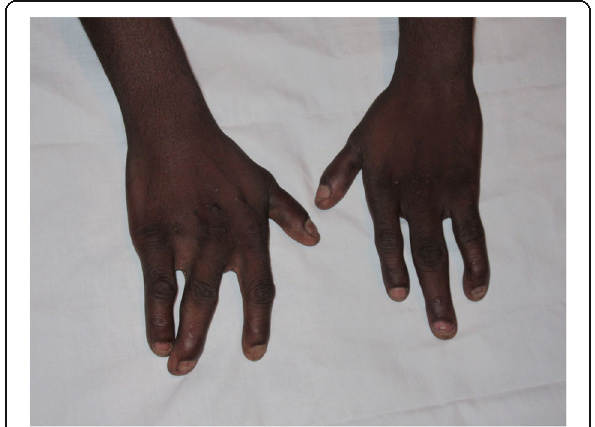
Fig. 2 Hand photo of proband II.1 showing bilateral Syndactyly